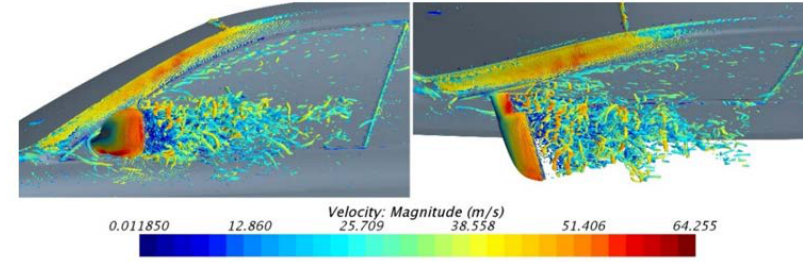
Figure 21. Isosurface map of Q criterion (side view and top view).